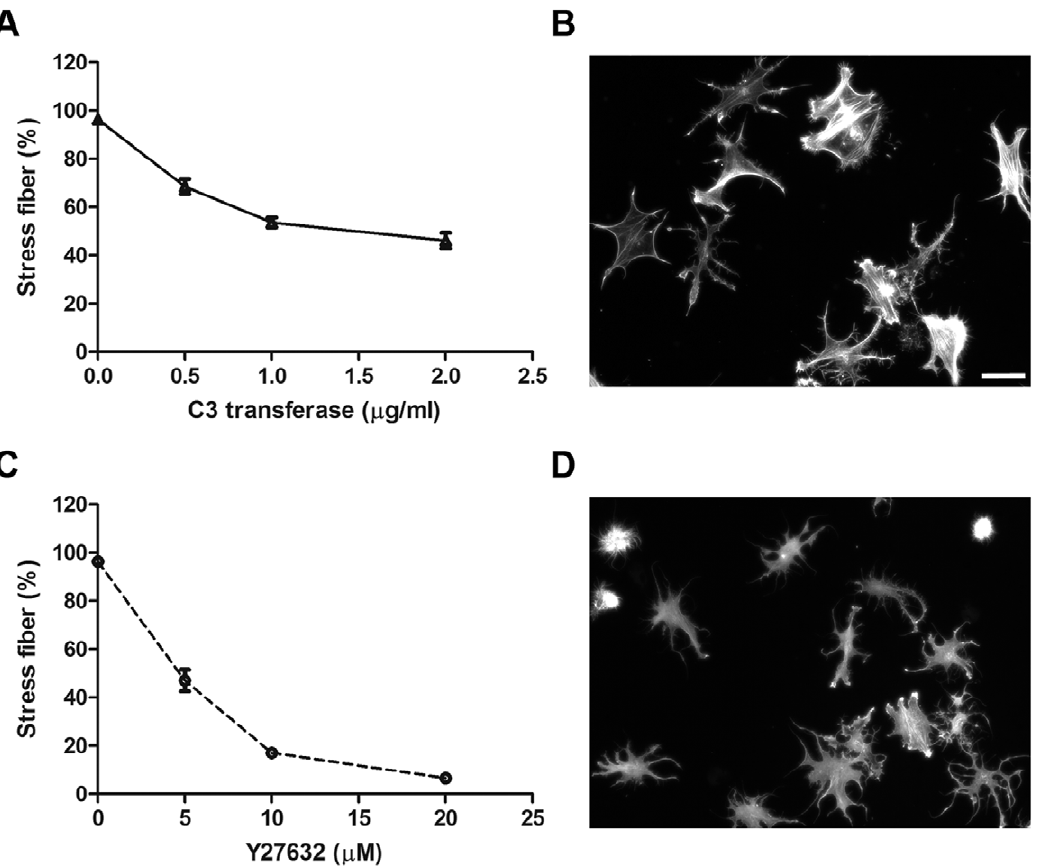
Figure 4. Rho and ROCK inhibitors inhibit Galectin-8 induced stress fiber formation. A and C: Serum-starved human TM cells were incubated on chamber glass slides coated with recombinant human Gal8 in the presence of the Rho inhibitor, C3 transferase or ROCK inhibitor, Y27632, at different concentrations. After 2 hr, cells were stained with rhodamine-labeled phalloidin, and cells with robust stress fibers were enumerated. Data are expressed as mean 6 SEM. B and D: Cells were treated C3 transferase at 2 m g/ml (B) or Y27632 at 20 m M (D), stained with rhodamine-labeled phalloidin, and random fields were photographed. Note that cells treated with Y27632 or C3 transferase are not spread and exhibit dendrite-like structures. Bar: 50 m m.